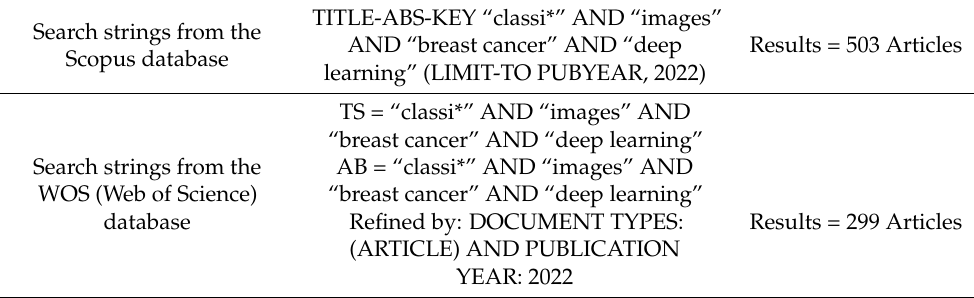
Table 1. Search strings from the Scopus and WOS databases.